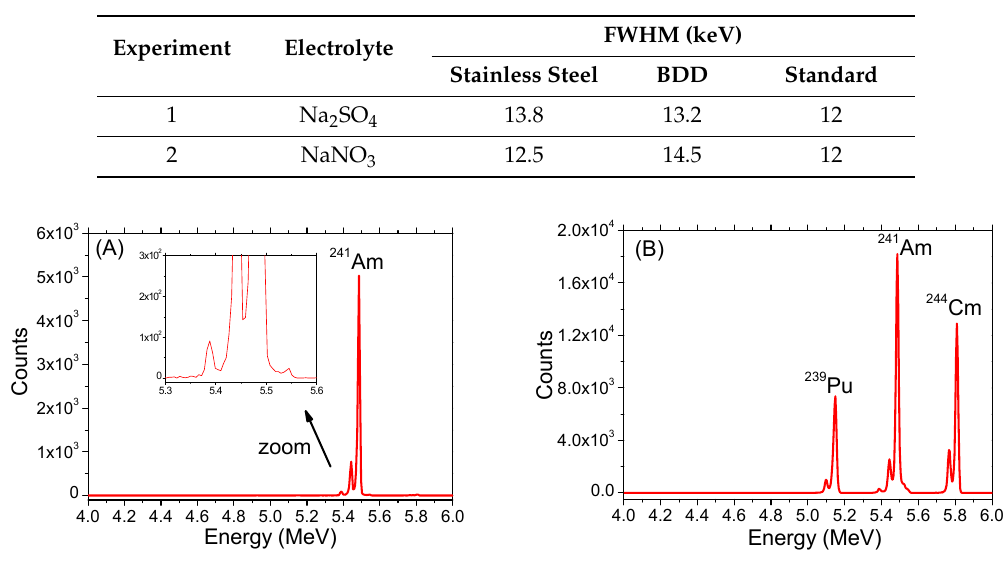
Table 1. FWHM of 5.96 Bq 241 Am electro-precipitated for t = 90 min: (1) 0.3 M Na 2 SO 4 pH 3.97 electrolyte, current density = 8 mA.cm − 2 , and (2) 0.3 M Na 2 SO 4 pH 3.0 electrolyte, current density = 3.3 mA.cm − 2 , t = 90 min.